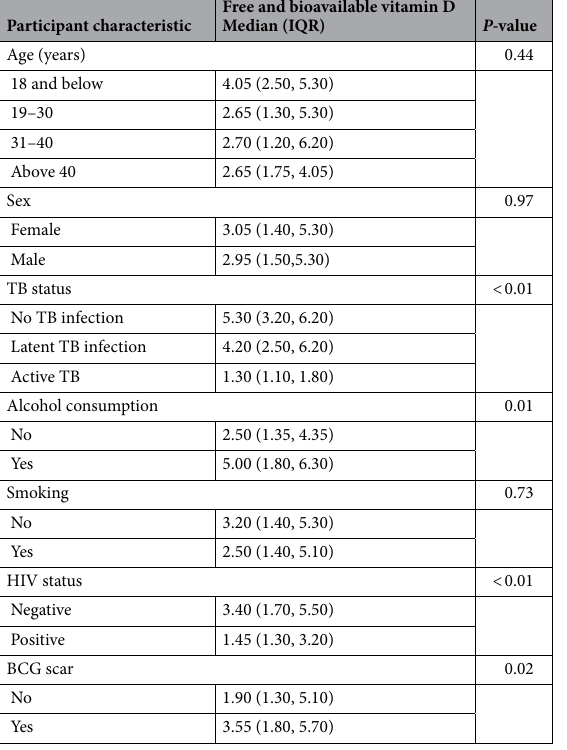
Table 1. Showing bioavailable, vitamin D median levels among social and clinical factors characteristics. Free vitamin D in ng/mL, P-value is < 0.05.